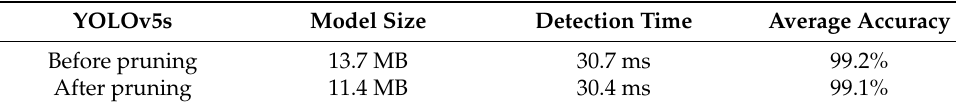
Table 3. Comparison of models before and after pruning.